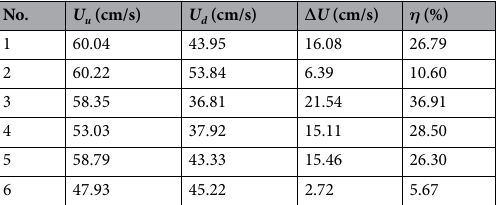
Table 2. Results of the mean velocities in each section and the corresponding rates of deceleration for each test. Note: U u = mean velocity in section upstream the TFPW; U d = mean velocity in section downstream of the TFPW; ∆ U = difference between the mean velocities in sections upstream and downstream of the TFPW; η = deceleration rate of the mean velocities in each